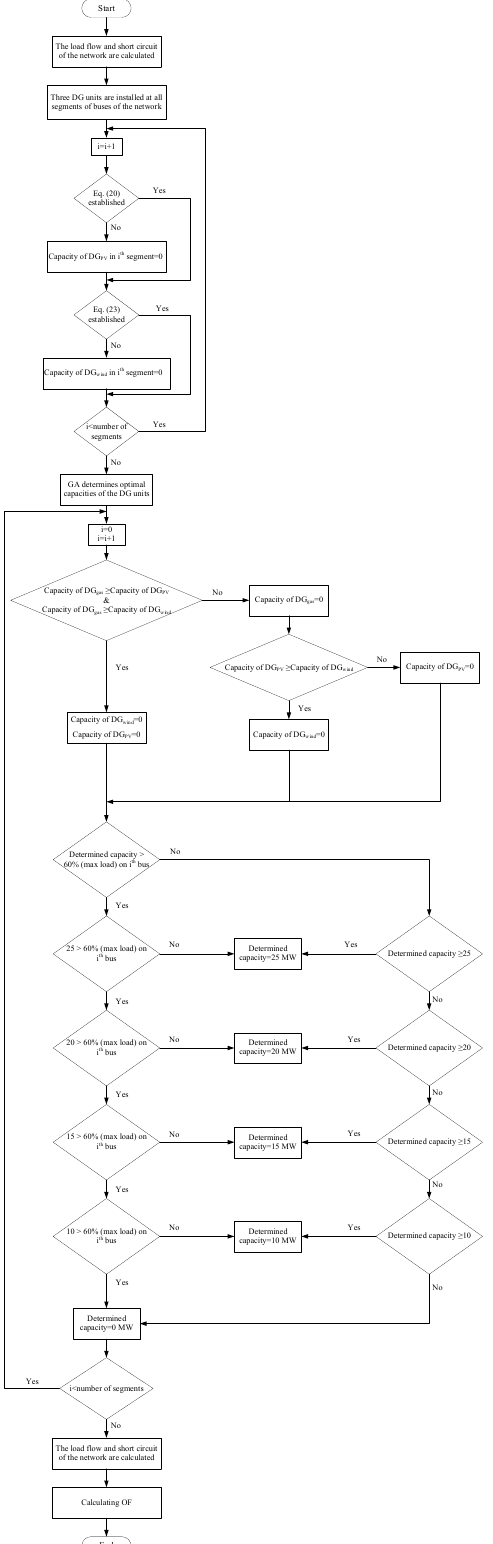
Figure 3. The flowchart of determining the optimal number, sizing and location of DG units.